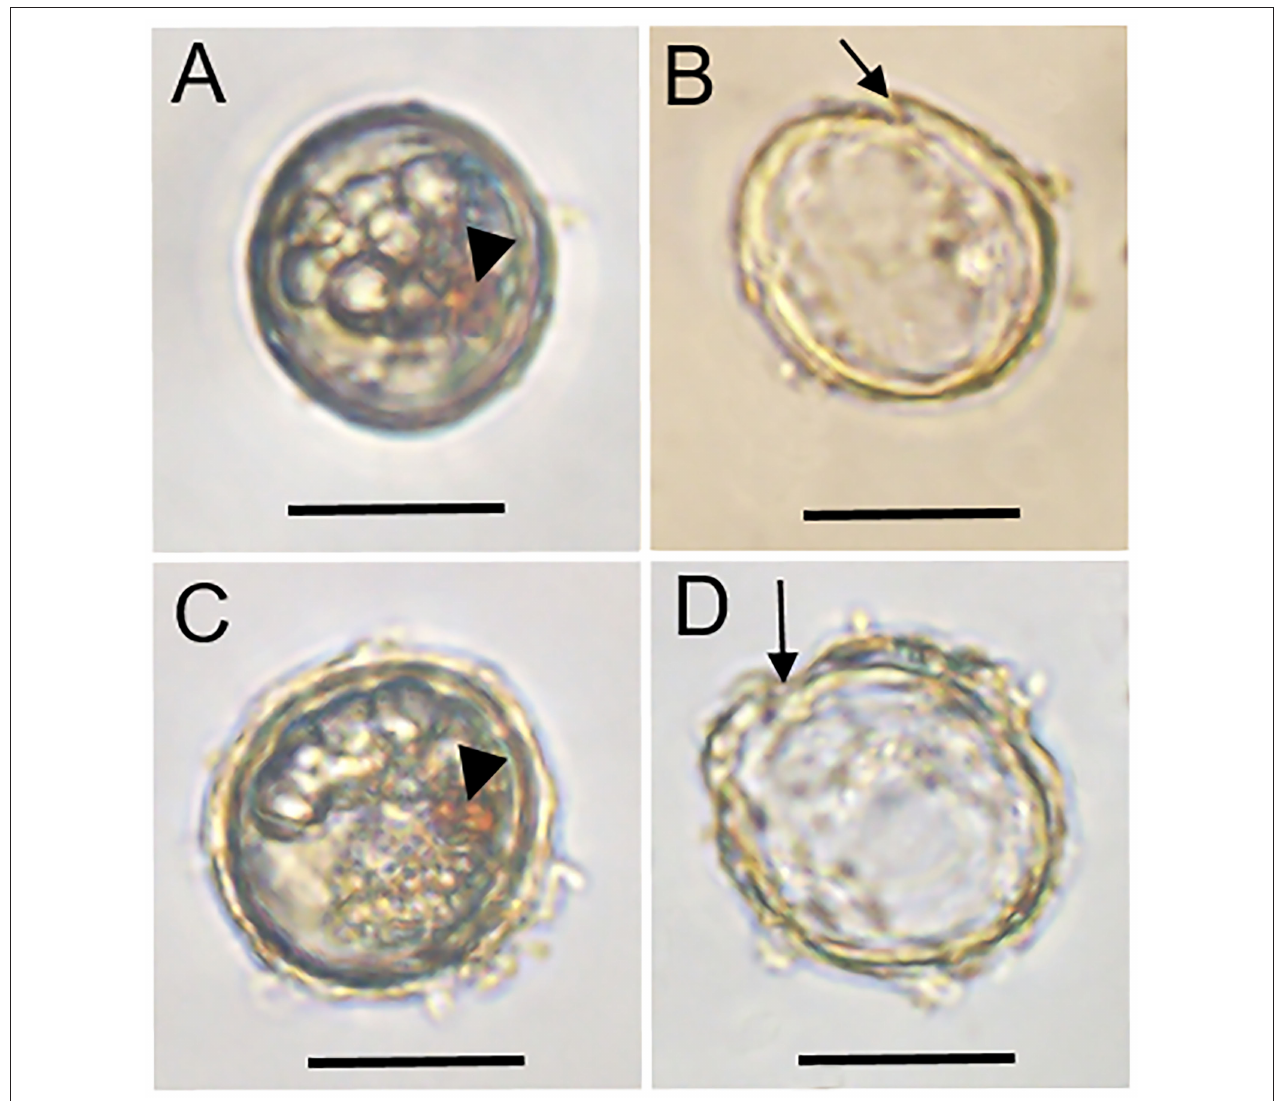
FIGURE 1 | Light microscopy micrographs of two living (A,C) and the corresponding empty (B,D) cysts of Alexandrium insuetum . Arrowheads indicate the red accumulation body, the archeopyle (arrow) appeared after cyst germination. Scale bars = 20 µ m.